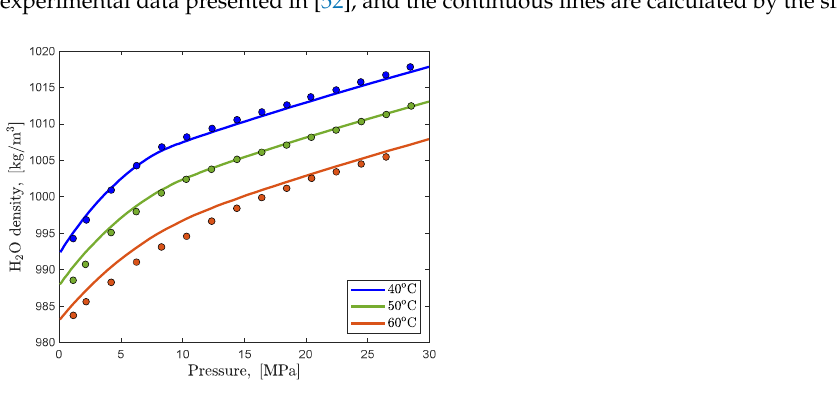
Figure 8. Density of CO2-saturated water as a function of temperature and pressure. The discrete points are experimental data presented in [57], and the continuous lines are calculated by the simulator.